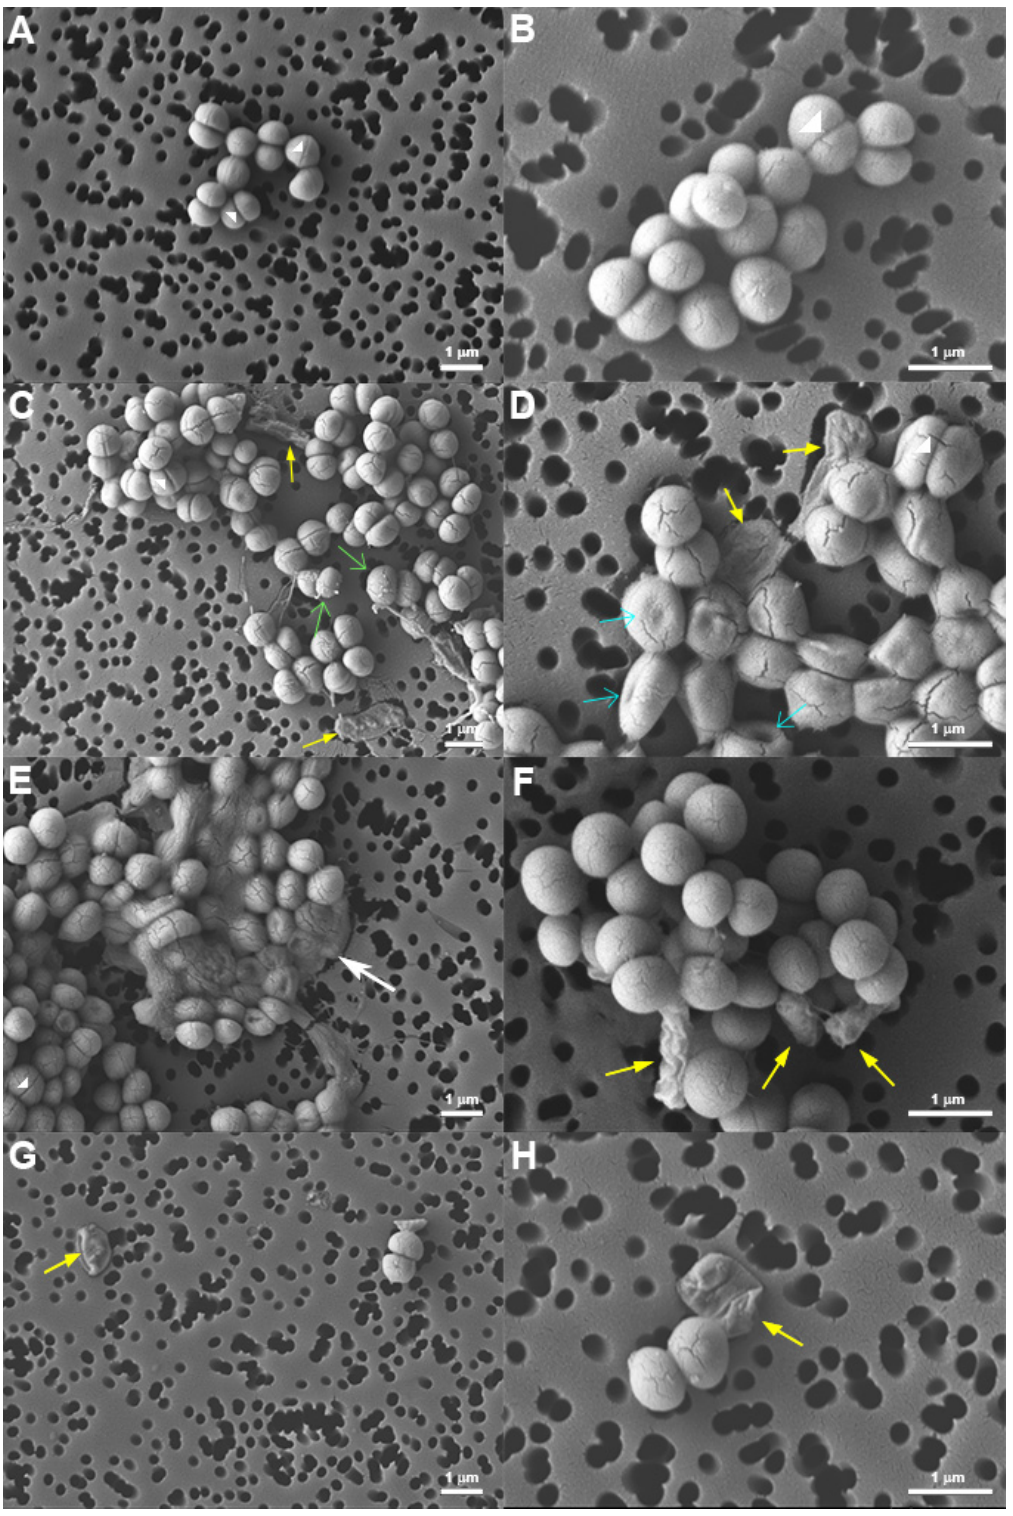
Figure 5. Morphology of S. epidermidis, untreated ( A,B ) or treated with 30 µM gramicidin D ( C,D ), 1 µM melittin ( E,F ) and 125 nM melittin ( G,H ) analyzed by Field Emission Scanning Electron Microscopy (FE-SEM). Arrows indicate, respectively, division septa ( ), blebs ( ), indents ( ), bacteria with altered morphology ( ), and deflated bags ( ). Representative images from two experiments performed in duplicate are shown.